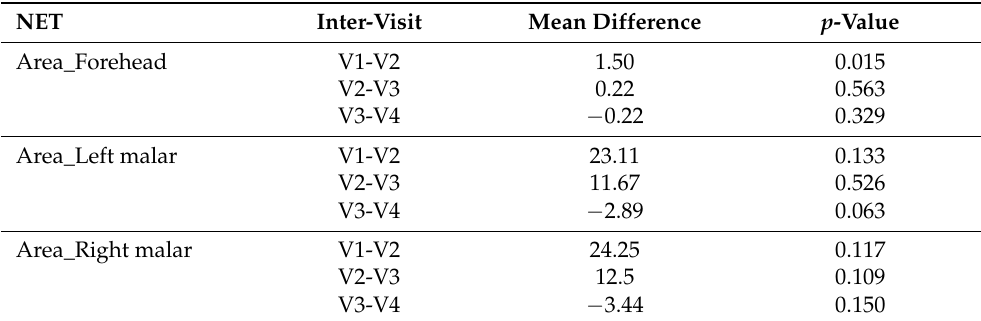
Table 4. Mean difference of NET (number of lesions exceeding the erythema threshold) between adjacent visits.